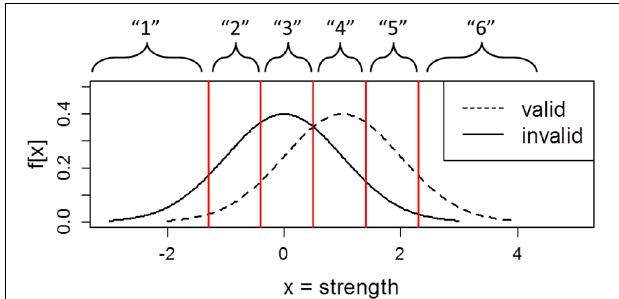
FIGURE 1 | Argument strength distributions of valid and invalid problems demonstrating the link between confidence ratings and response